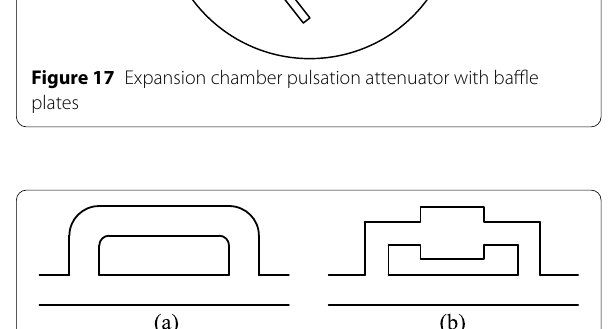
Figure 18 Interference type pulsation attenuators: a original type, b improved